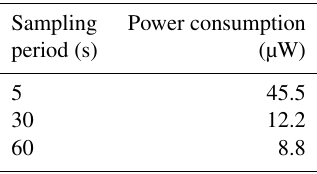
Table 4. Comparison of the power consumption (µW) of the plat- form with different sampling